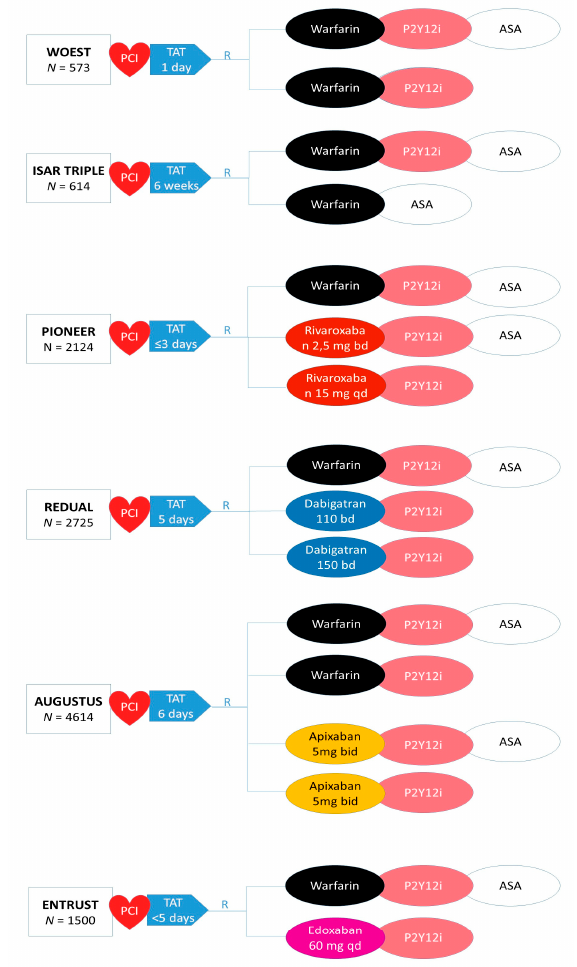
Figure 3. Design of clinical trials exploring the combination of oral anticoagulants and antiplatelet agents in patients with non-valvular atrial fibrillation undergoing percutaneous coronary intervention.